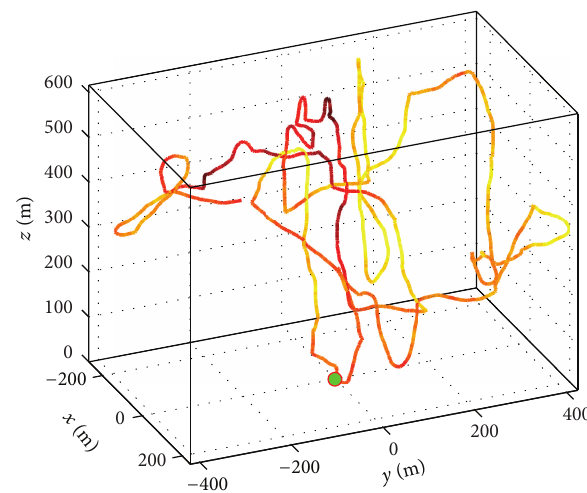
Figure 1: Diagram of CARATE components for variable 𝜙 ( 𝑁 5 ).